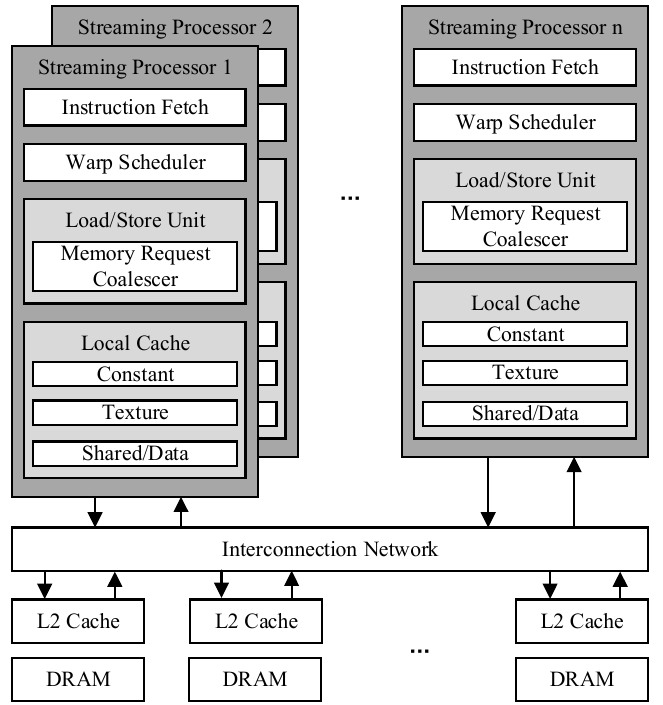
Figure 1. Baseline GPU